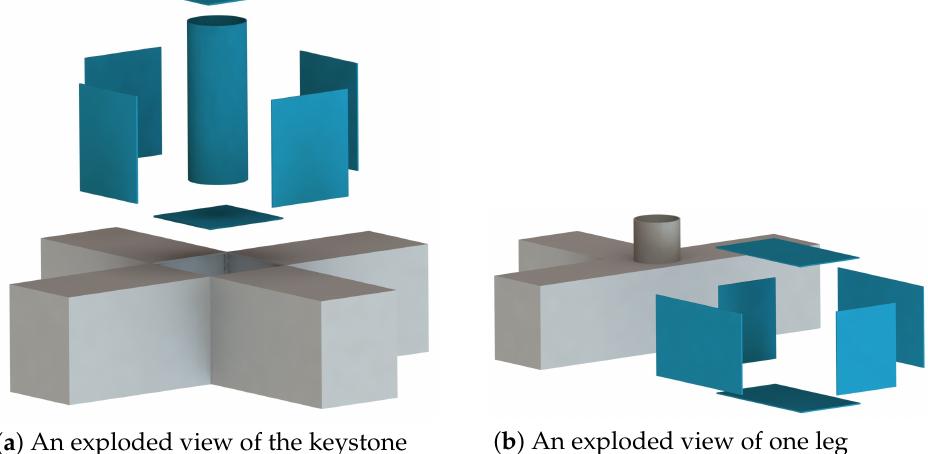
Figure 7. Exploded views of the keystone ( a ) and one leg ( b